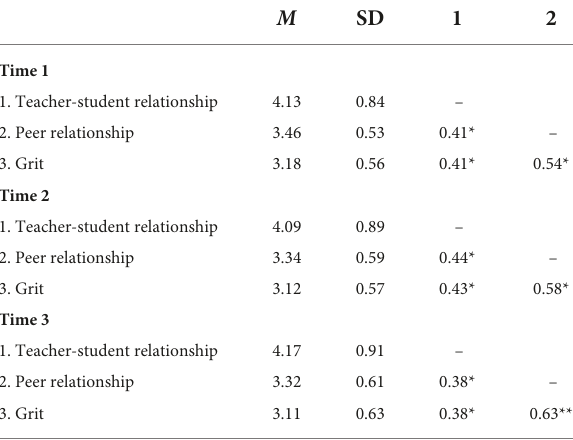
TABLE 2 Descriptive statistics and pearson correlation coefficients among